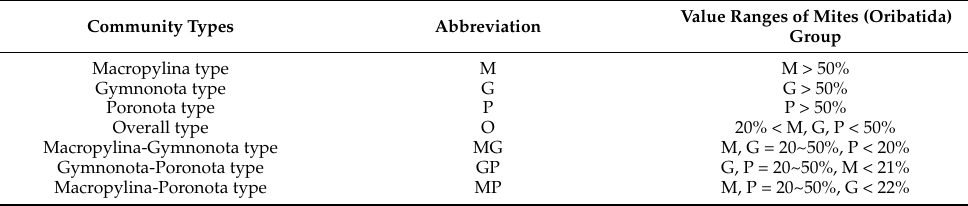
Table 2. Measurable standard of community types on oribatid mites (Acari:Oribatid). Community